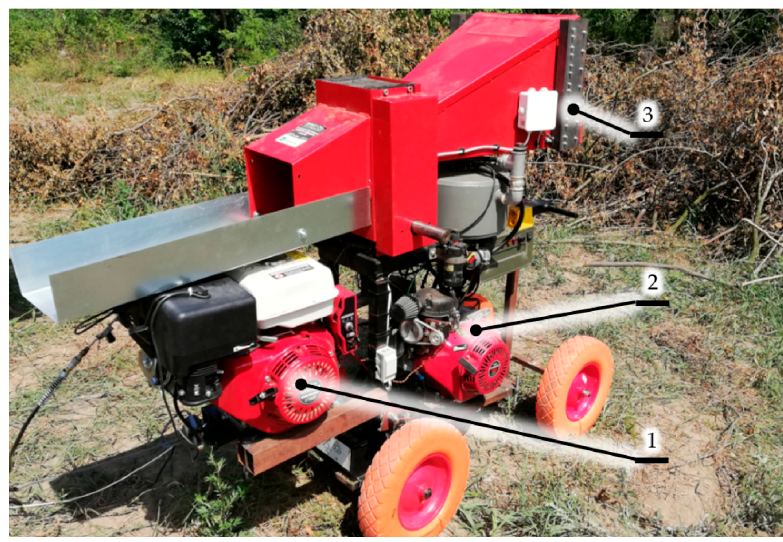
Figure 1. Cylindrical woodchipper: 1: small engine with a carburettor fuel supply system; 2: small engine with an injector fuel supply system, with an adaptive system as an option; 3: optical detection system in the feed channel.